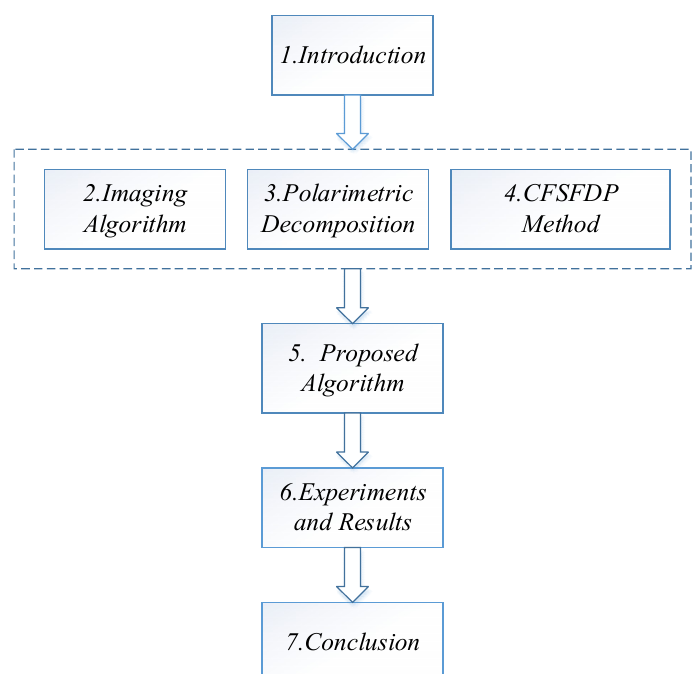
Figure 1. The framework of the contents.